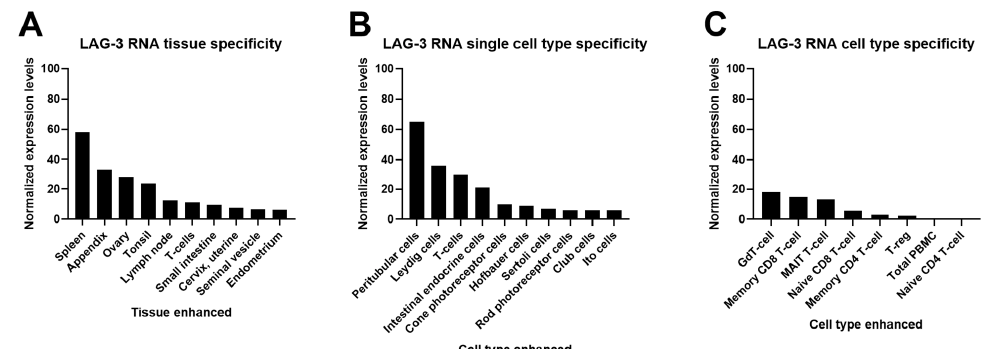
Figure 3. LAG-3 protein and RNA expression profiles from Protein Atlas Analyses (http://www.proteinatlas.org; accessed on 2 May 2021). Images and data credit: Human Protein Atlas. Image and data available from: LAG3 protein expression profiles, The Human Protein Atlas. ( A ) LAG-3 consensus normalized expression (NX) levels for 55 tissue types and 6 blood cell types, created by combining the data from the three transcriptomics datasets (HPA, GTEx, and FANTOM5), using the internal normalization pipeline. Color coding is based on tissue groups by common functional features. RNA tissue specificity is enhanced in lymphoid and ovary tissues. ( B ) Summary of LAG-3 single-cell RNA (NX) from the indicated single cell types. Color coding is based on cell type groups, each consisting of cell types with functional features in common. ( C ) The bar graph represents quantification of RNA-seq data (pTPM) from blood cell types and total peripheral blood mononuclear cells (PBMC) that have been separated into subpopulations by flow sorting.